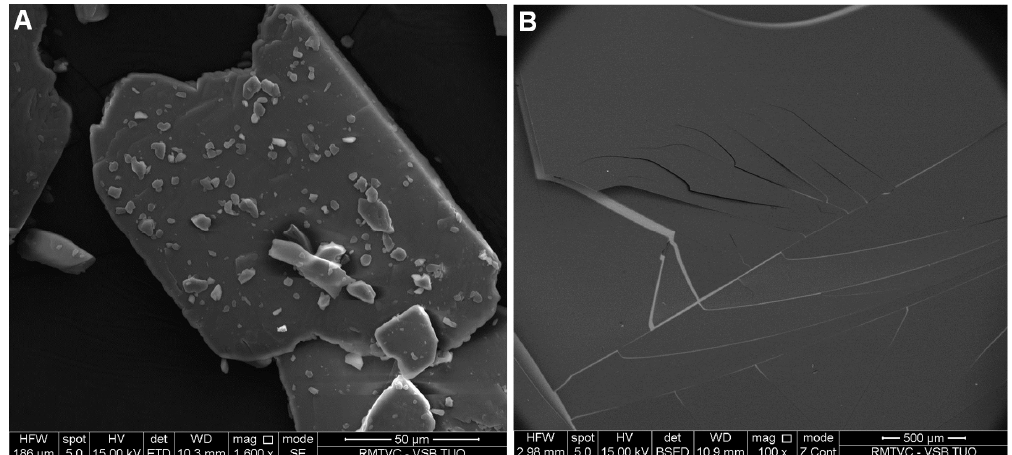
Figure 3. SEM images of bulk hydrochlorothiazide at magnification 1600× ( A ) and hydrochlorothiazide stabilized with 5% carboxymethyl dextran sodium salt (sample 5c ) at magnification 100× ( B ).